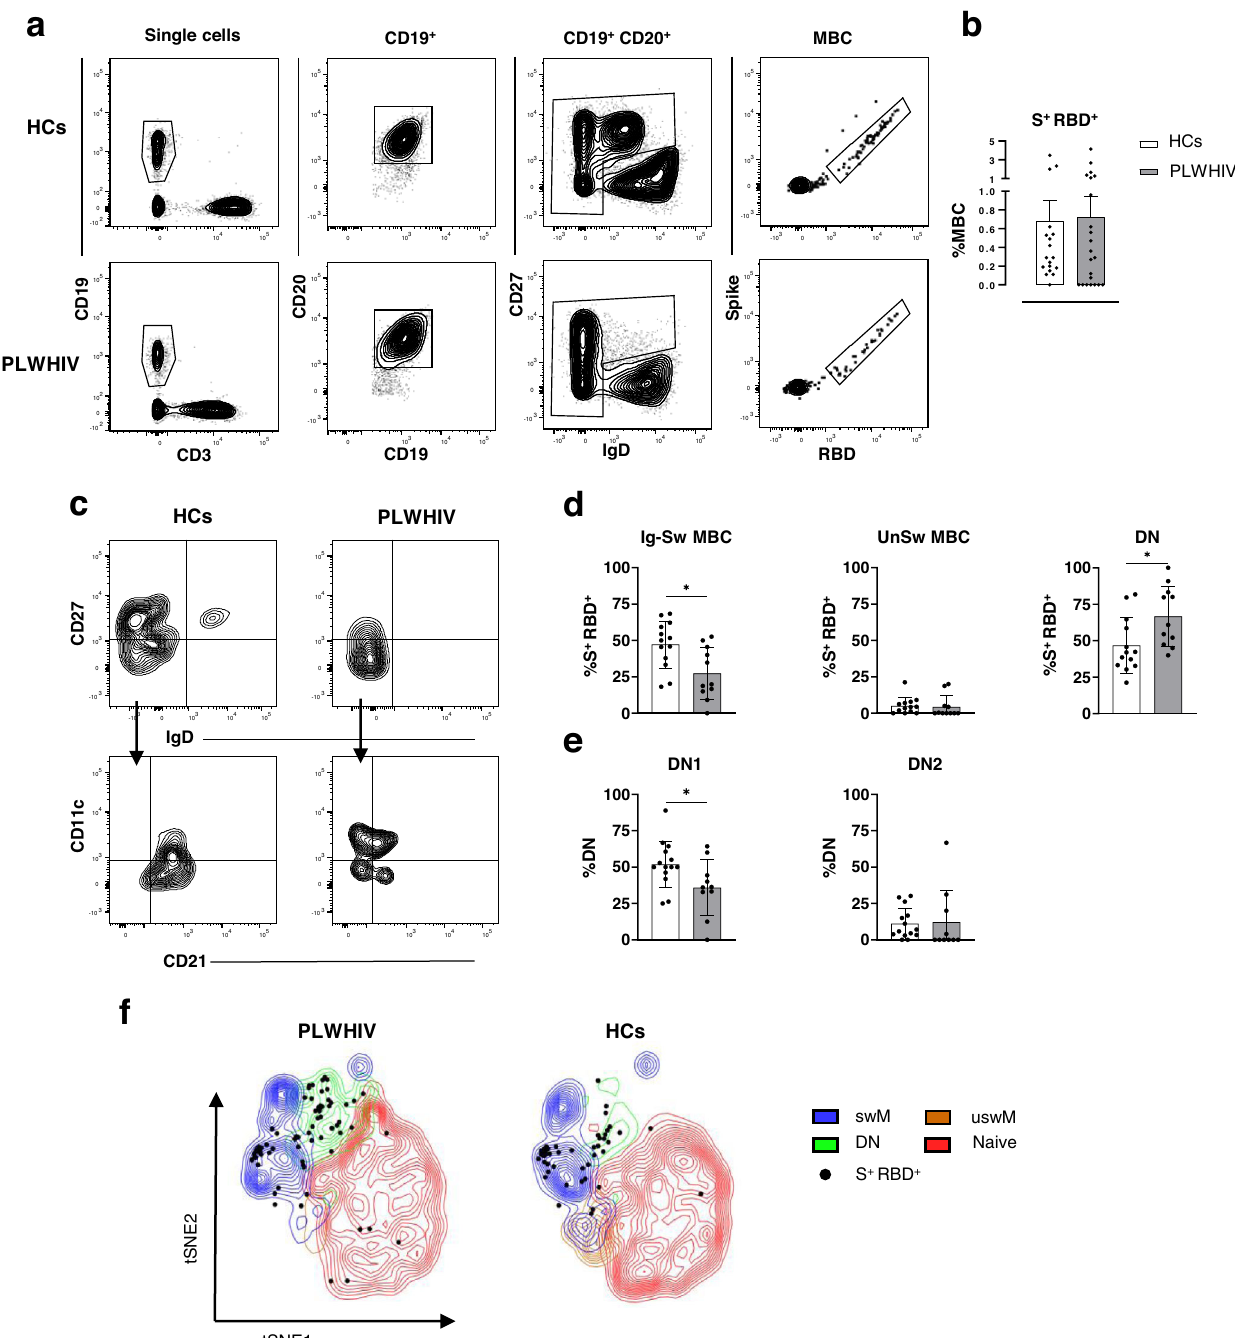
Fig. 3 Analysis of spike-speci fi c memory B cells at 6 months after the beginning of the vaccination cycle ( + 150 v2). a Gating strategy applied for identifying S + RBD + MBC in PLWHIV and HCs. b Percentages of S + RBD + cells identi fi ed within MBC pool in each group. c Contour plot analysis of CD27 vs. IgD within S + RBD + MBC, for identifying Ig-switched (IgD - CD27 + ), Unswitched (IgD + CD27 + ) and double-negative (DN) (IgD - CD27 - ) MBC. The DN MBC were dissected according to CD11c and CD21 expression for the identi fi cation of DN1 (CD11c - CD21 + ) and DN2 (CD11c + CD21 - ) d-e Percentages of S + RBD + MBC subsets identi fi ed in c. Contour plot in a and c are representative from a single subject from each group. Statistical difference was assessed by Mann – Whitney test; * P ≤ 0.05. f t-SNE visualization of B cells and antigen-speci fi c B cells in PLWHIV and HCs. t-SNE dimensionality reduction was used to visualize in a bidimensional space a multiparametric dataset. Major B-cell subsets (switched memory, swM; unswitched memory uswM; double negative, DN; and naive) from PLWHIV (left) and HCs (right) were displayed as contour plots in t-SNE map according to the expression of all analyzed markers. S + RBD + B cells were shown as black dots. Sample size b , f : PLWHIV ( n = 22), HCs ( n = 18). Sample size c - e : PLWHIV ( n = 10), HCs ( n = 13). All samples were biologically